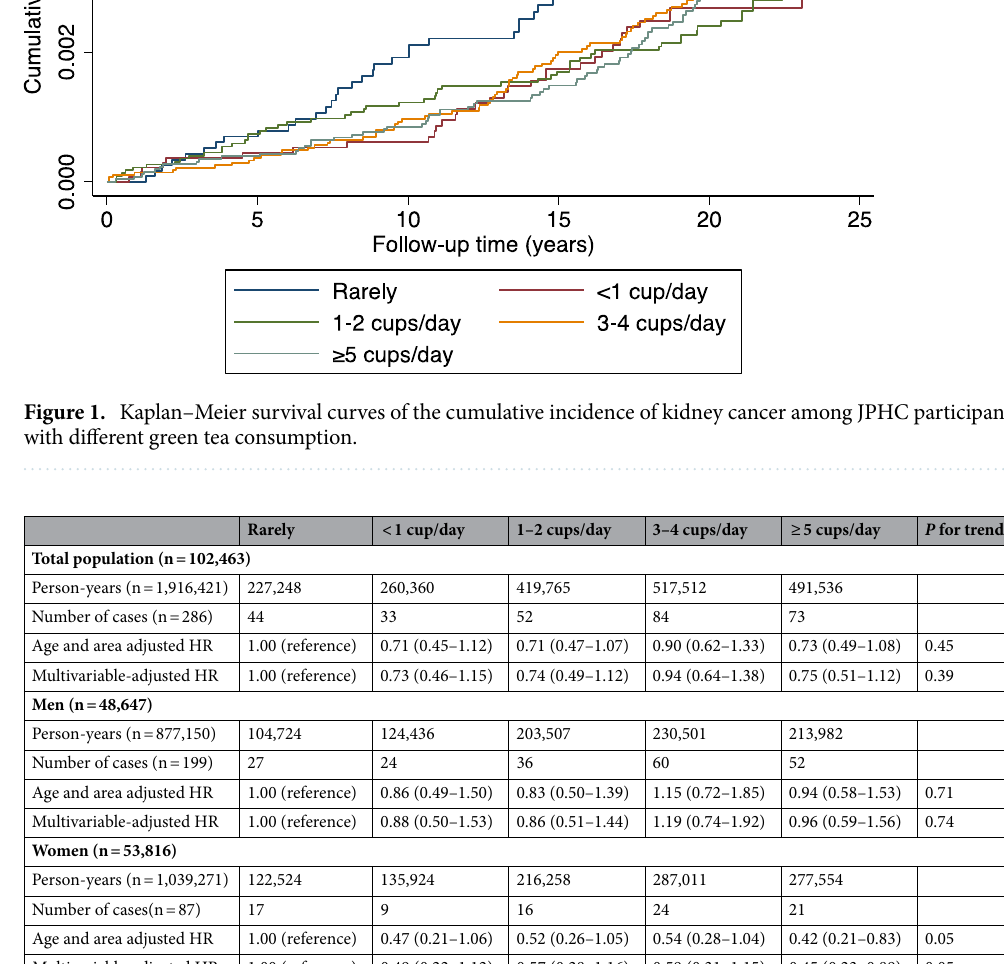
Table 3. Hazard ratio and 95% confidence interval for kidney cancer incidence according to green tea consumption in Japanese adults. a In multivariable-adjusted models for men and women, adjusted variables included age (stratified by age groups: 45–49, 50–54, 55–59, 60–64, 65–69 and > 70 years old), sex (men and women), PHC area (stratified by 10 areas), smoking (past, current, never, missing), history of hypertension (yes, no, missing), history of diabetes (yes, no, missing), history of renal diseases (yes, no, missing), drinking frequency (rarely, 1–3 days/month, 1–2 days/week, 3–4 days/week, ≥ 5 days/week, missing), body mass index (< 18, 19–22, 23–25, 26–29, > 30, missing), physical activity (rarely, 1–3 days/month, 1–2 days/week, 3–4 days/ week, almost daily, missing). Models were mutually controlled coffee consumption. In the models for the total population, in addition to these variables, sex was also